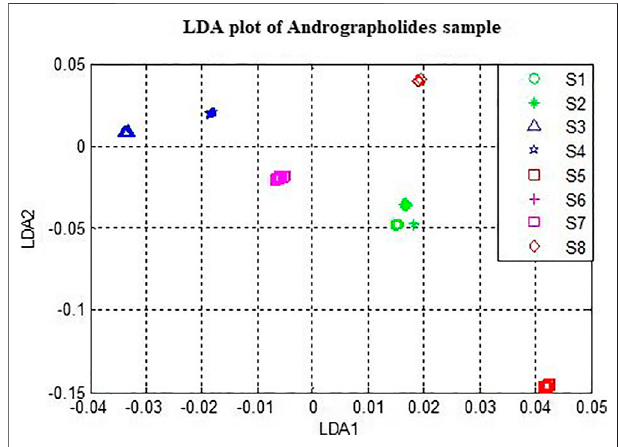
FIGURE 7 | LDA plot with fi rst two